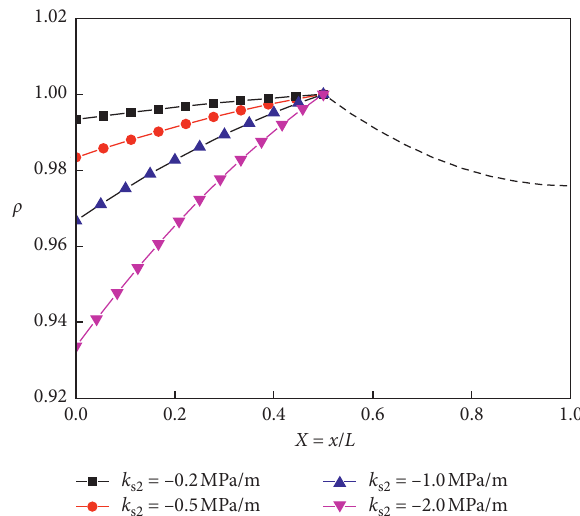
Figure 22: Effect of the interface frictional resistance at stage II on L s .